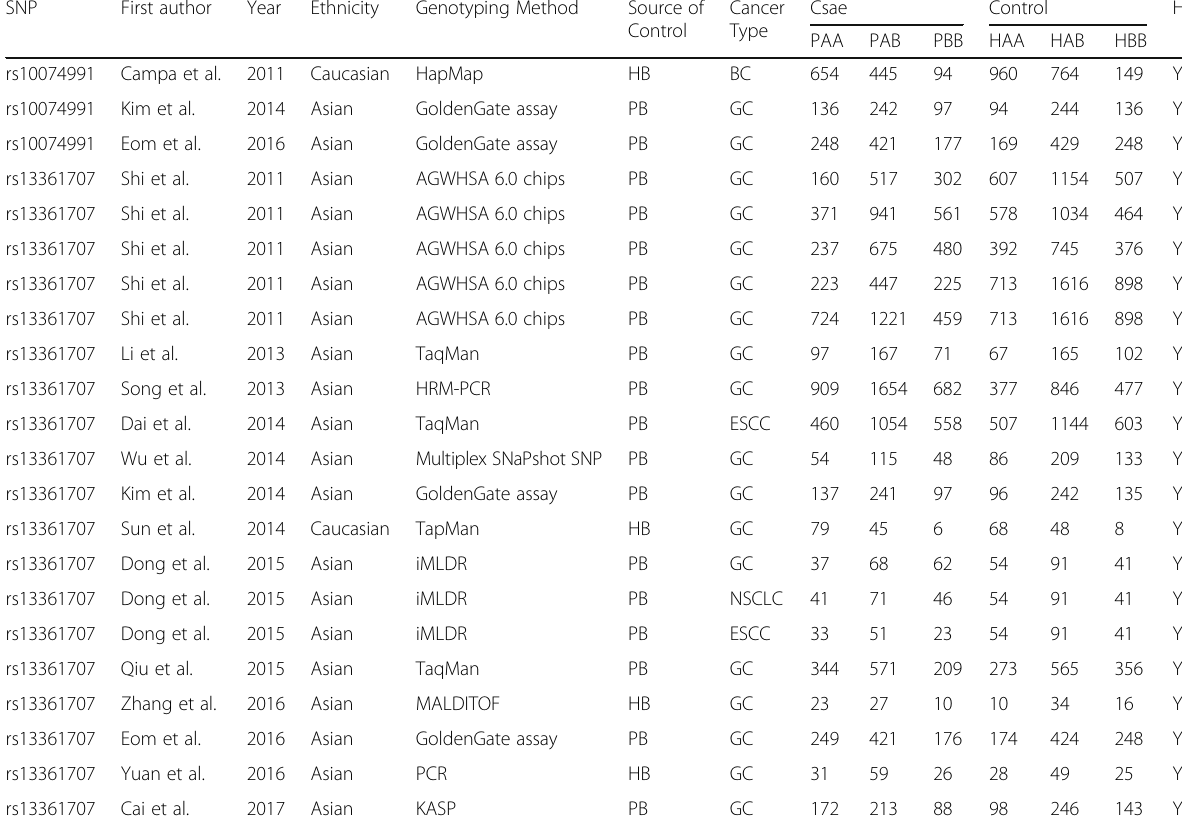
Table 1 Characteristics of the enrolled studies on PRKAA1 polymorphisms and